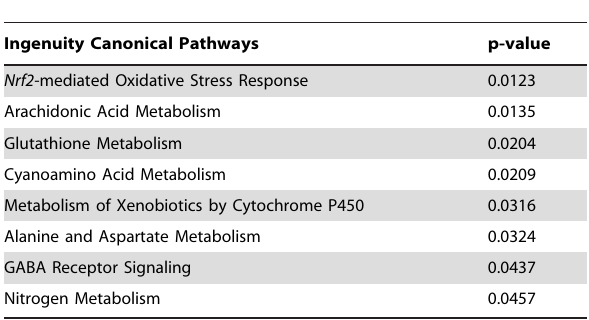
Table 4. Pathway analysis of gene expression in morphologically normal prostate tissue in men who took fish oil supplements for three months (n=27) compared with placebo